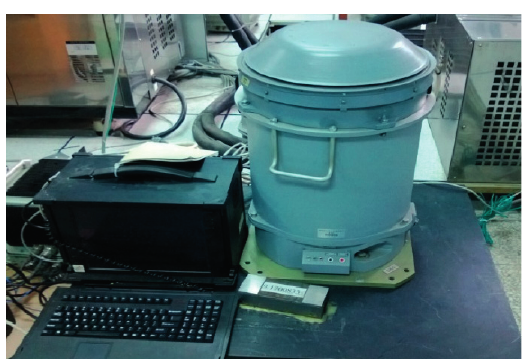
Figure 17. Chekan-AM marine